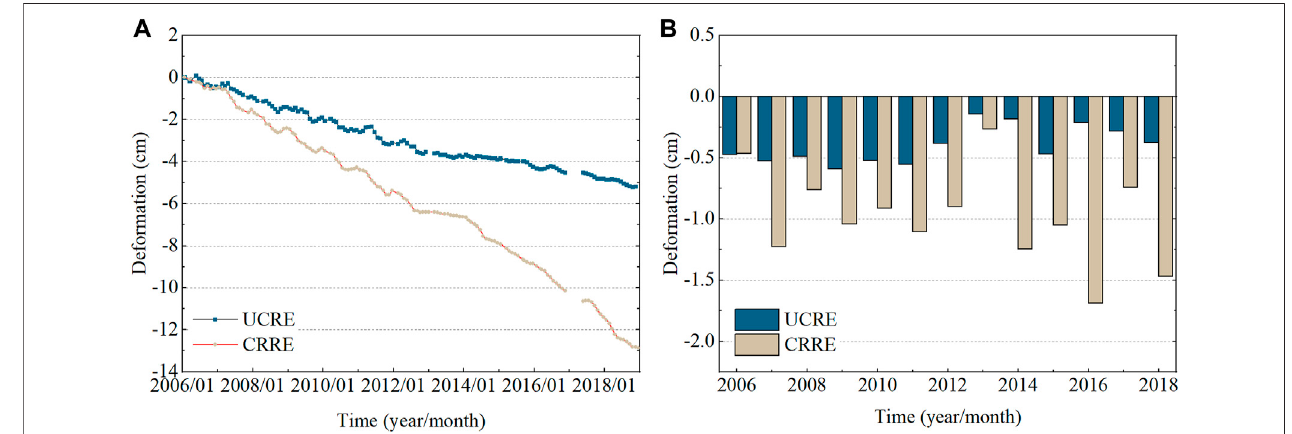
FIGURE 9 | Cumulative deformation (A) and annual deformation (B) of the UCRE and